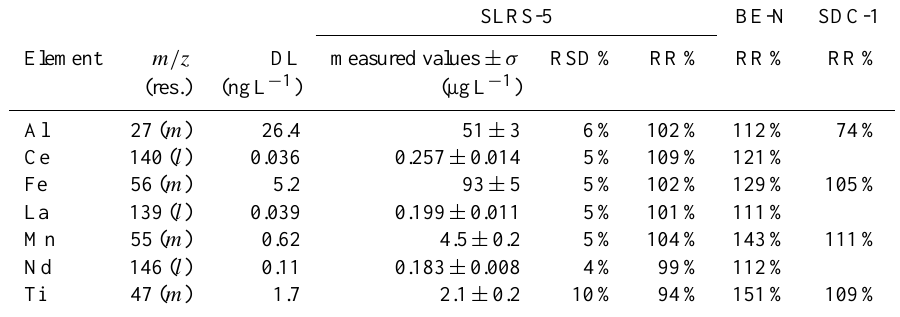
Table 1. Detection limits, accuracy and reproducibility of SLRS-5 measurements, estimated recovery rate of BE-N and SDC-1.